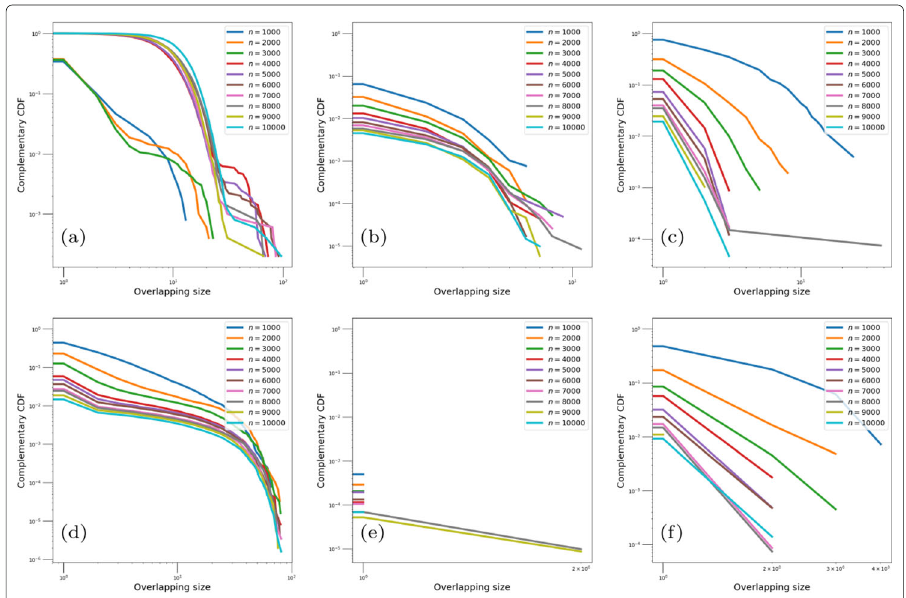
Fig. 17 Variation of the number of nodes ( n ) for LFR synthetic networks considering the overlapping size and: a Bigclam; b CFinder; c Copra; d Demon; e SLPA; f Ground-Truth